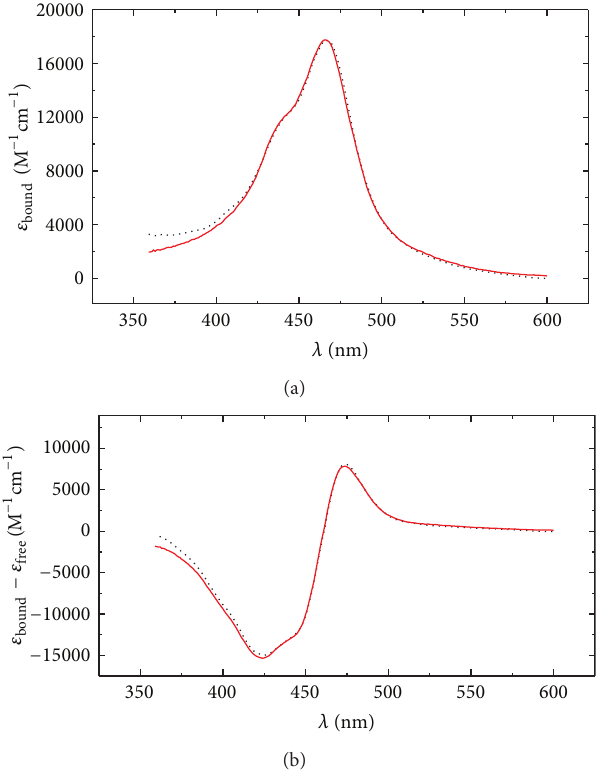
Figure 10: The (𝜀 𝐵 − 𝜀 𝐹 ) and 𝜀 𝐵 spectra determined using SVD- basedbindedanalysiscomparedwithdirectlymeasuredcoefficients. The solid lines represent the measured data, and the dash lines represent the results for extinctions coefficients determined by SVD and model